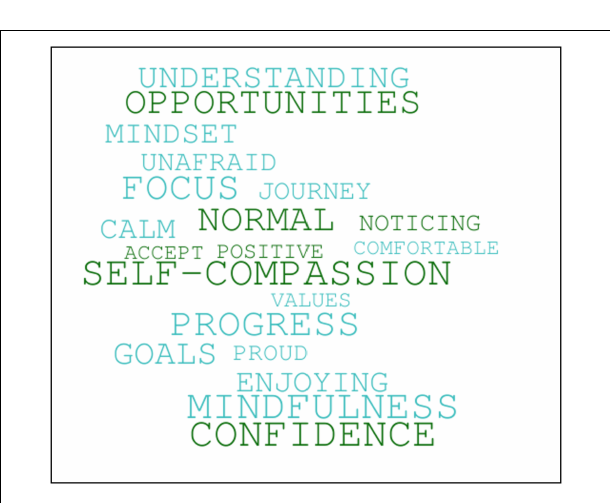
FIGURE 13 | Students’ use of more psychologically flexible language at Session 6, as revealed through emotion coding of their verbatim qualitative